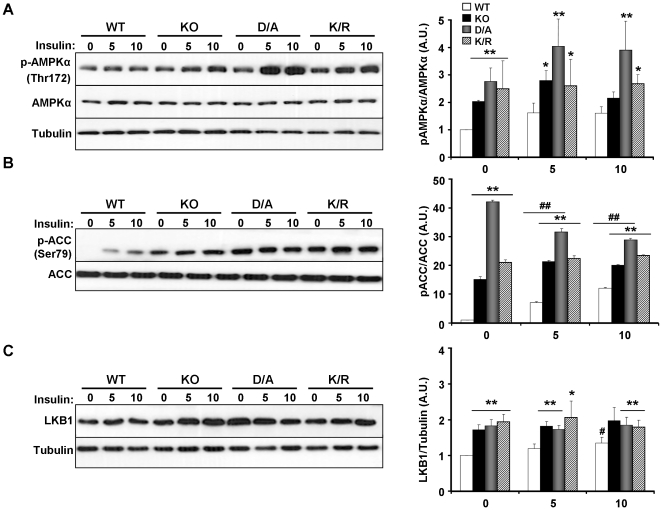
Altered AMPK signaling in PTP1B KO and reconstituted adipocytes.
A) Immunoblotting of AMPKα subunit phosphorylation (Thr172) in differentiated KO and reconstituted brown adipocytes under starved and insulin-stimulated conditions. Phosphorylation of ACC (Ser79) (B), and LKB1 expression (C) in differentiated WT, KO, D/A and K/R cells at basal and insulin-stimulated conditions. Bar graphs are data from three independent experiments and are presented as means ± SEM. (*) indicates statistically significant difference between KO, D/A or K/R and WT under the same treatment condition, while (#) indicates statistically significant difference between WT, KO, D/A or K/R and their corresponding basal (no insulin).